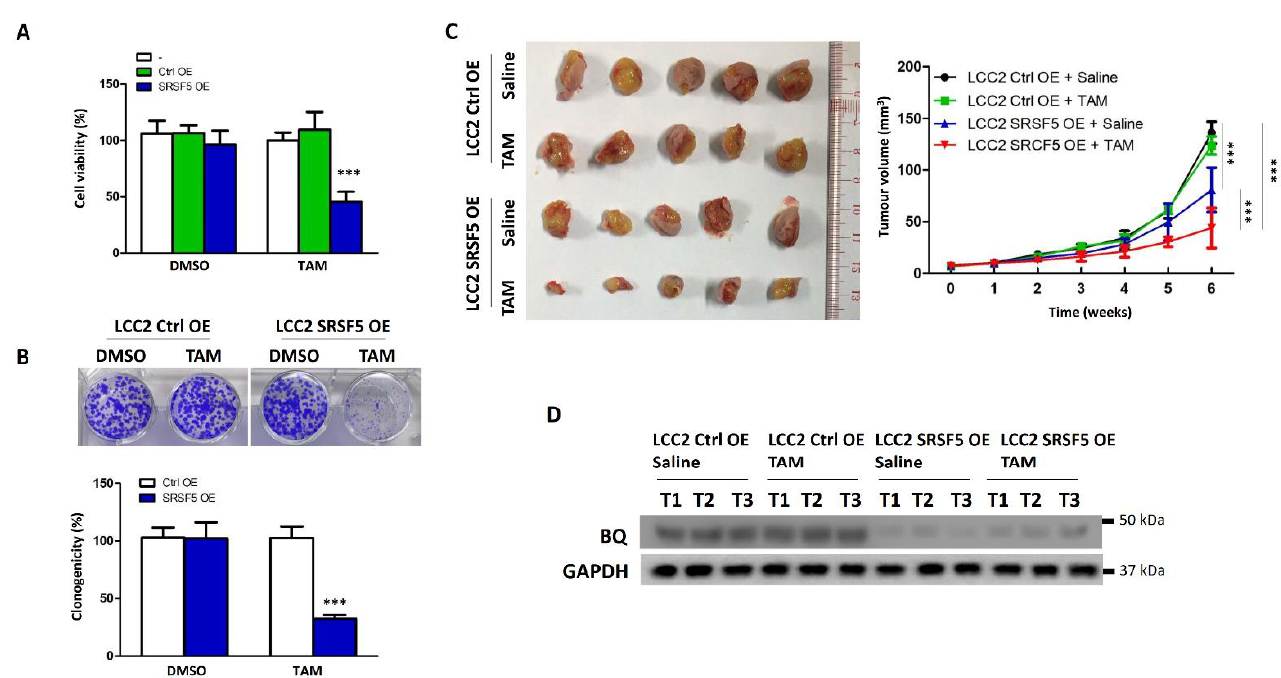
Figure 4. Overexpression of SRSF5 could compromise tamoxifen (TAM) resistance. ( A ) Overexpres- sion of SRSF5 could make LCC2 sensitive to TAM. An amount of 5 µ M of TAM was employed to treat the cells. After 96 h of treatment, cell viability was assayed. Results are shown in the bar chart as mean value of cell viability ± SD from five independent experiments. Statistical significance compared with the untreated group was determined using a one-way ANOVA with a Bonferroni post hoc test. ( B ) Clonogenic assay indicated the effect of SRSF5 overexpression on TAM resistance in LCC2. An amount of 5 µ M of TAM was employed to treat LCC2 cells for 3 weeks. The bar chart shows the results of mean value of cell viability ± SD from five independent experiments. Statistical significance between Ctrl OE and SRSF5 OE was determined by students’ t -test. ( C ) Overexpression of SRSF5 could recover the sensitivity to TAM in vivo. LCC2 Ctrl OE and LCC2 SRSF5 OE cells were engrafted onto the mammary fatpad of female nude mice. TAM or saline was given to the mice via subcutaneous injection. One-way ANOVA with Bonferroni post hoc test was used to determine the statistical significance between indicated groups. ( D ) Overexpression of SRSF5 could reduce BQ ex- pression in the tumour tissues. Proteins were extracted from the tumour tissues, and Western blot was employed to determine BQ expression. Protein lysates from 3 independent tumours from each of the groups were analysed. GAPDH was the loading control. *** represents p < 0.001.